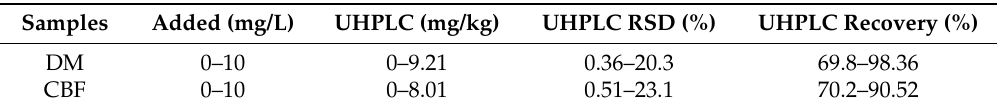
Table 2. The ultra high performance liquid chromatography (UHPLC) detection results of 83 samples of DM and CBF in soil with different